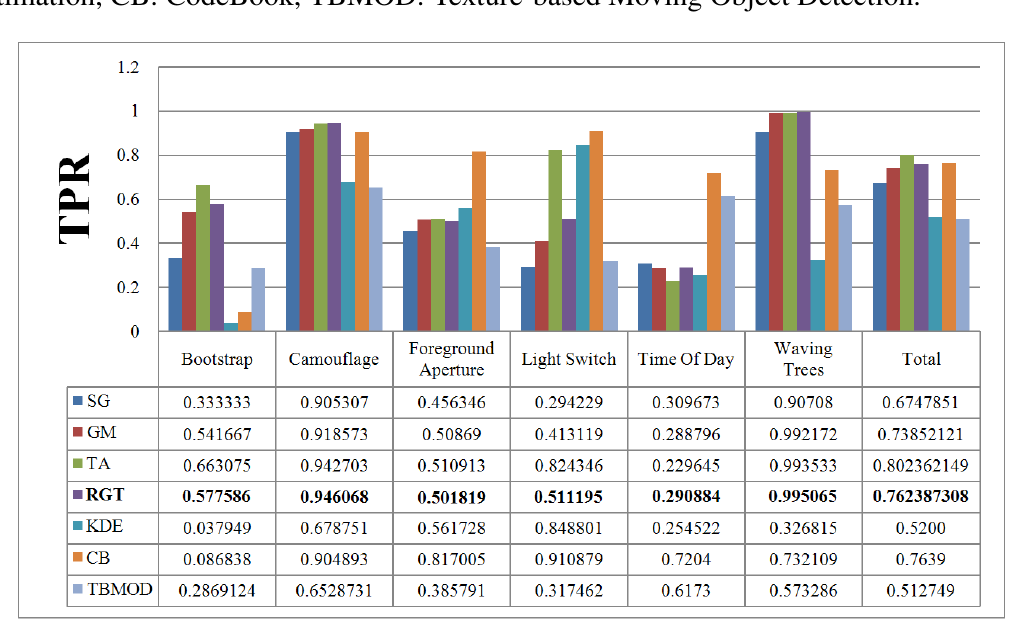
Figure 7. True Positive Rate of various background subtraction methods for the Wallflower dataset. The Total column represents the combination of all videos. SG: Single Gaussian,